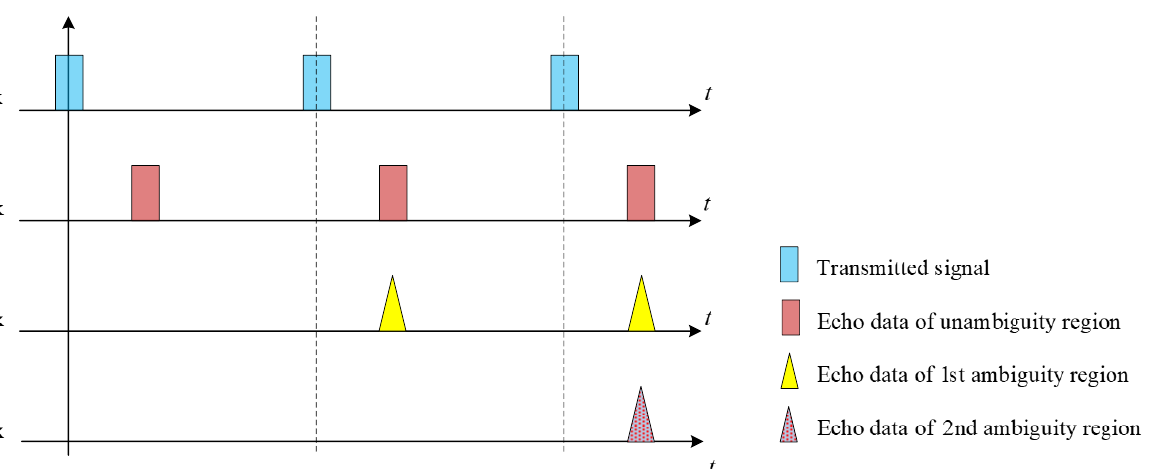
Figure 2. The echo signals of different ambiguous regions.